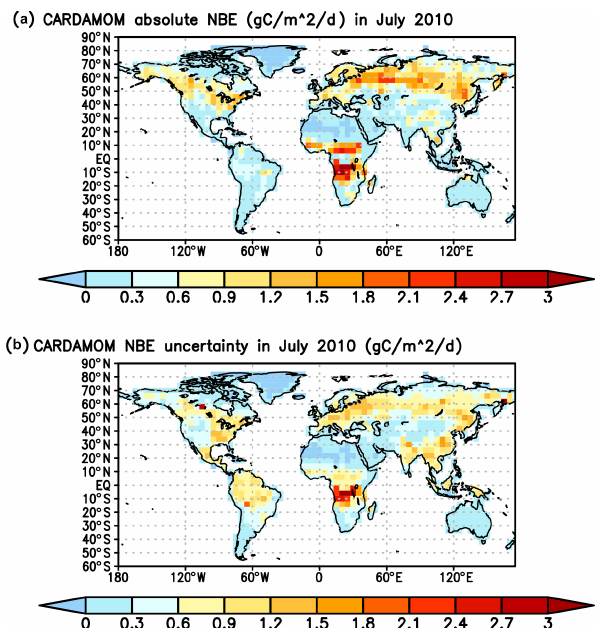
Earth Syst. Sci. Data, 13, 299–330,